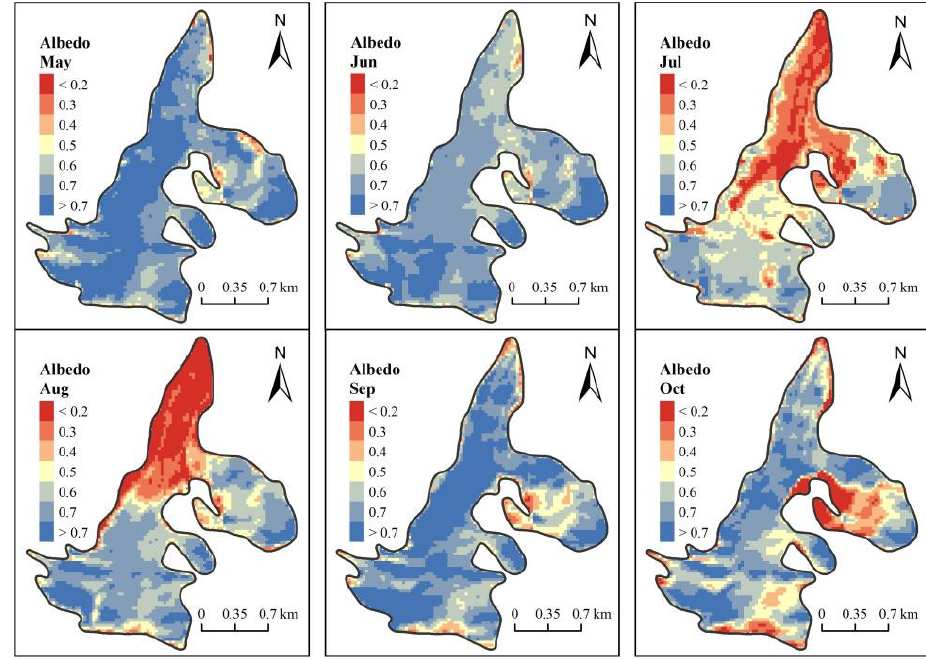
Figure 3. Spatial distribution of glacier surface albedo derived from Landsat images near the melt season in the different periods.